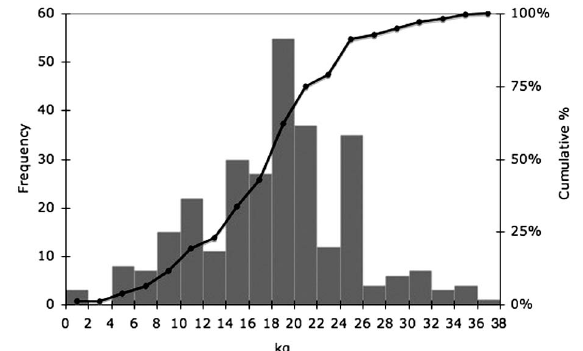
Fig . 2. – Fishery of P. pollicipes in the RNB: frequency and cumula- tive frequency distribution of the average amount of barnacles (2 kg size classes) landed per harvester per day